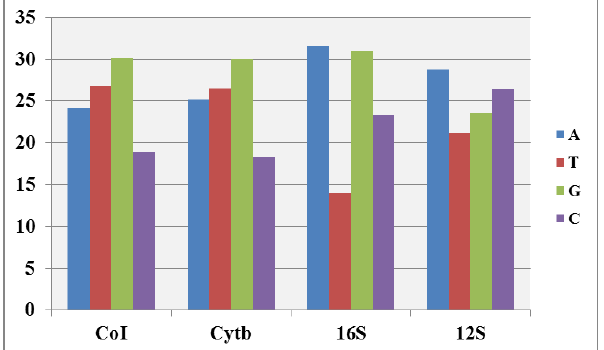
Fig. 2. The nucleotide substitution patterns of four mitochon- drial genes based on the Kimura (1980) 2-parameter model (Ts-Transition; Tv-Transversion; R-estimated Transition/ Transversion bias)